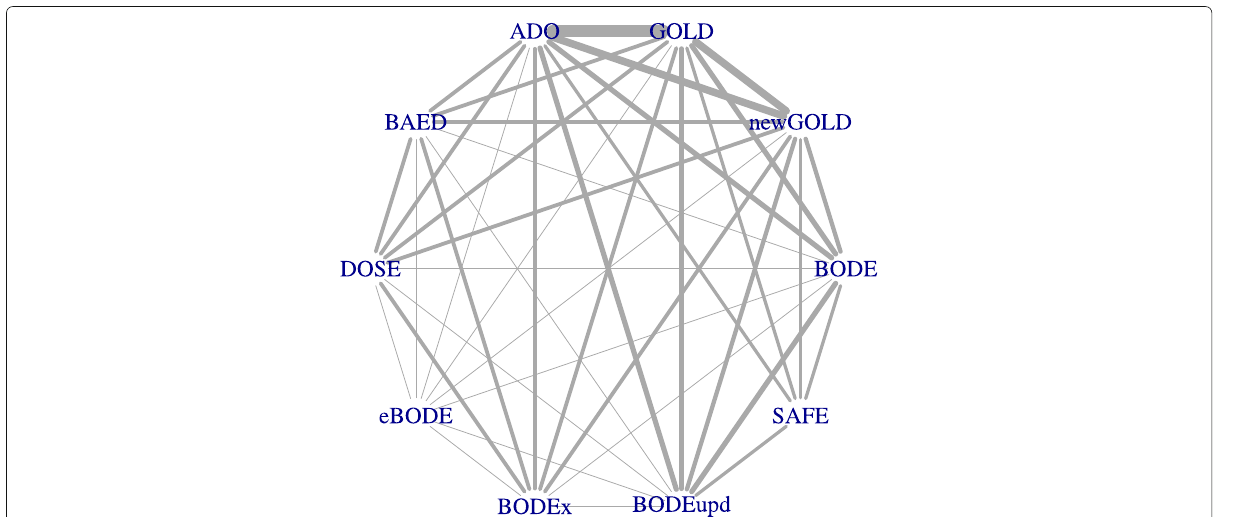
Fig. 5 Validation of 10 prognostic models for 3-year mortality in patients with chronic obstructive pulmonary disease.Depiction of network structure with lines weighted by the total number of participants available for each model comparison [74]. Abbreviations: GOLD, Global initiative for chronic Obstructive Lung Disease; BODE, Body mass index, airflow Obstruction, Dyspnoea and severe Exacerbations; BODE upd., BODE updated; ADO, Age, Dyspnoea, airflow Obstruction (we use the updated version of the ADO score in our analysis); e-BODE, severe acute exacerbation of COPD plus BODE; BODEx, Body mass index, airflow Obstruction, Dyspnoea, severe acute Exacerbation of COPD; DOSE, Dyspnoea, Obstruction, Smoking and Exacerbation frequency; SAFE, Saint George’s Respiratory Questionnaire (SGRQ) score, Air-Flow limitation and Exercise capacity; B-AE-D, Body-mass index, Acute Exacerbations,